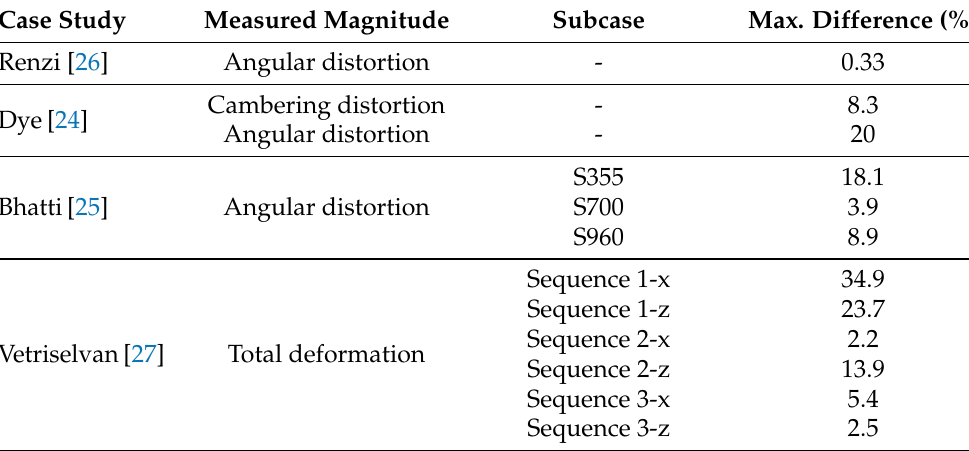
Table 3. Summary table. Accuracy of the presented